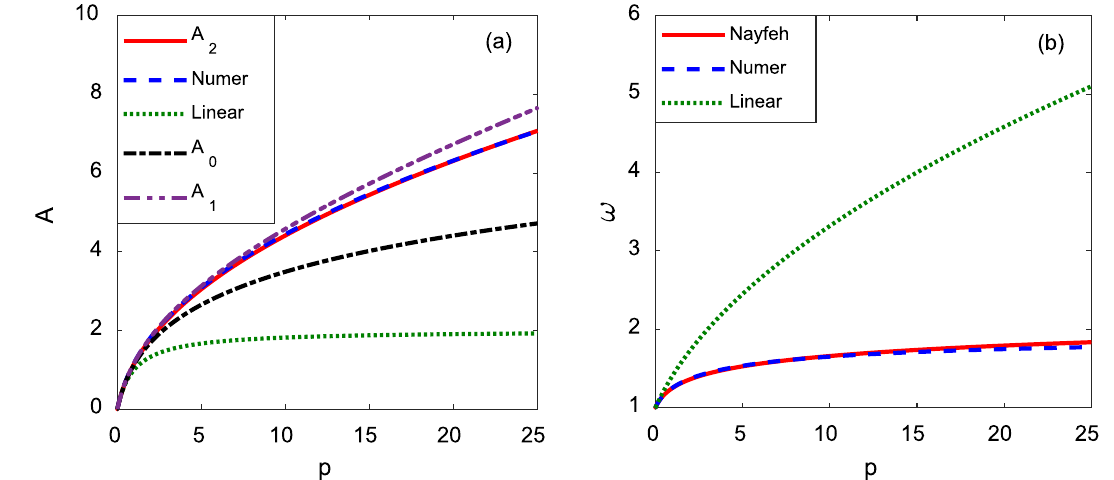
Figure 3. Numerical and approximate analytical values of maximum deflection ( a ) and frequency ( b ) vs. parameter p .